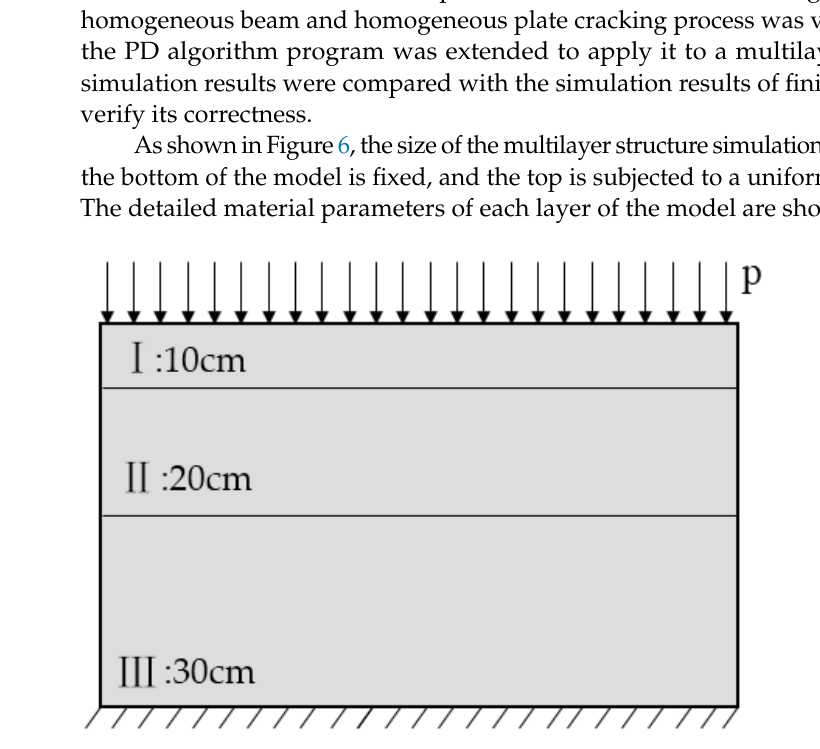
Figure 6. Multilayer structure model.